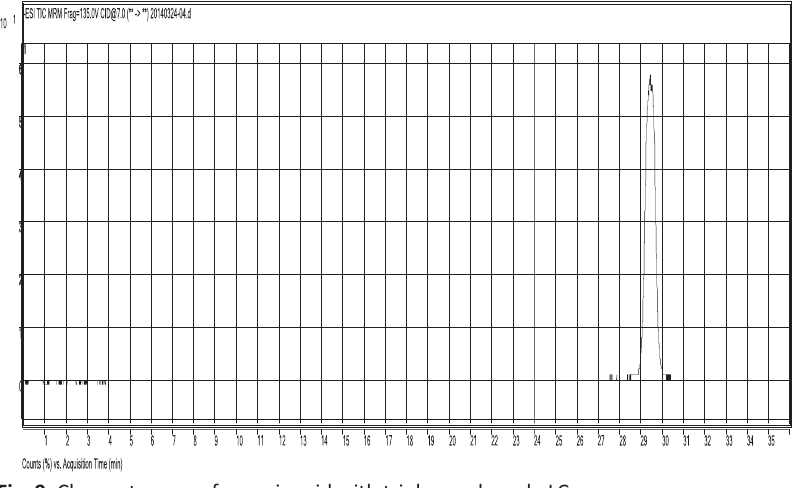
Fig. 8. Spectrum. of citric acid with triple quadrupole LC